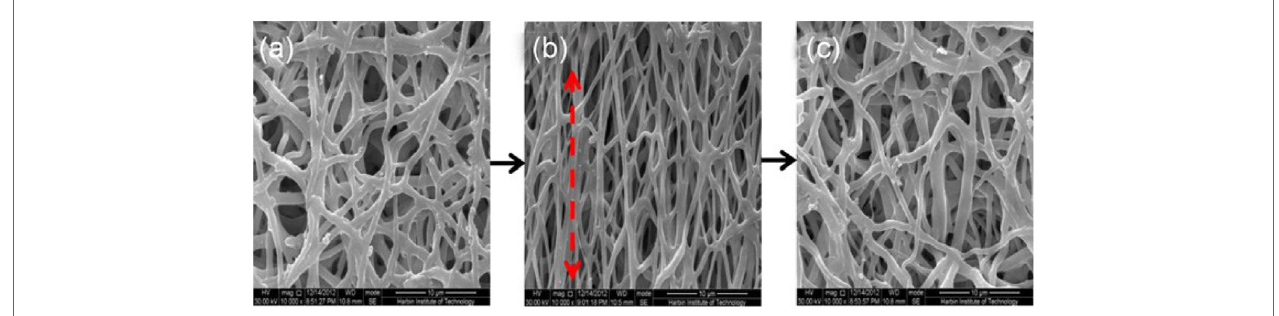
FiGURe 2 | SeM images of Nafion nanofibers, (a) the original fibers, (b) the stretched fibers, and (c) recovered fibers. (With kind permission from Springer Science + Business Media Zhang et al.,